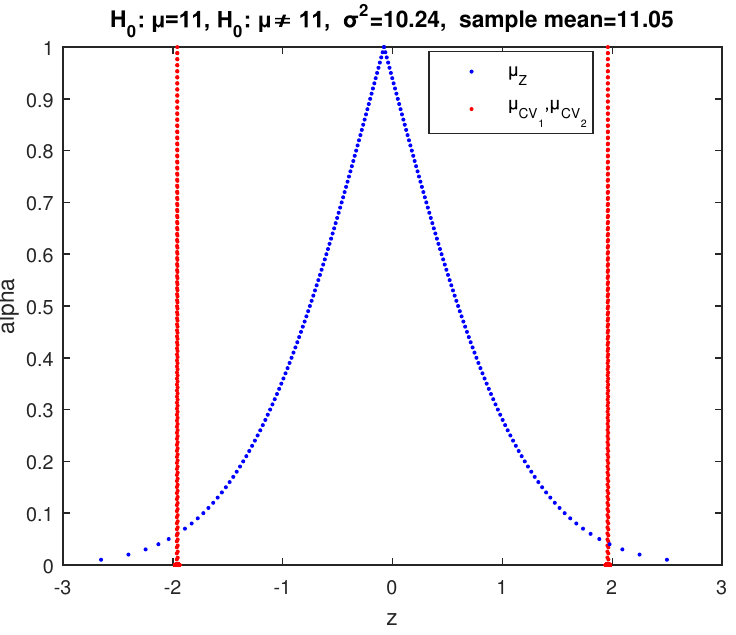
Figure 6. The possibility distribution of the fuzzy statistic (cid:101) Z for the two-sided test of Example